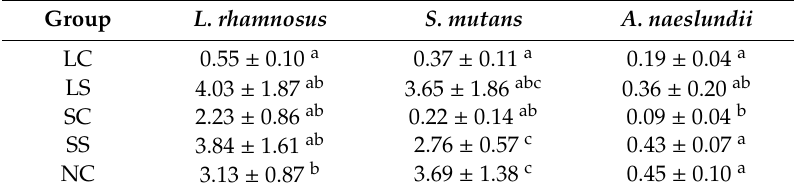
Di ff erent superscript letters indicate the statistically significant di ff erence between experimental groups within each column measured on the same time point ( p < 0.05); if groups share minimum one letter there was no significant di ff erence detected ( p >